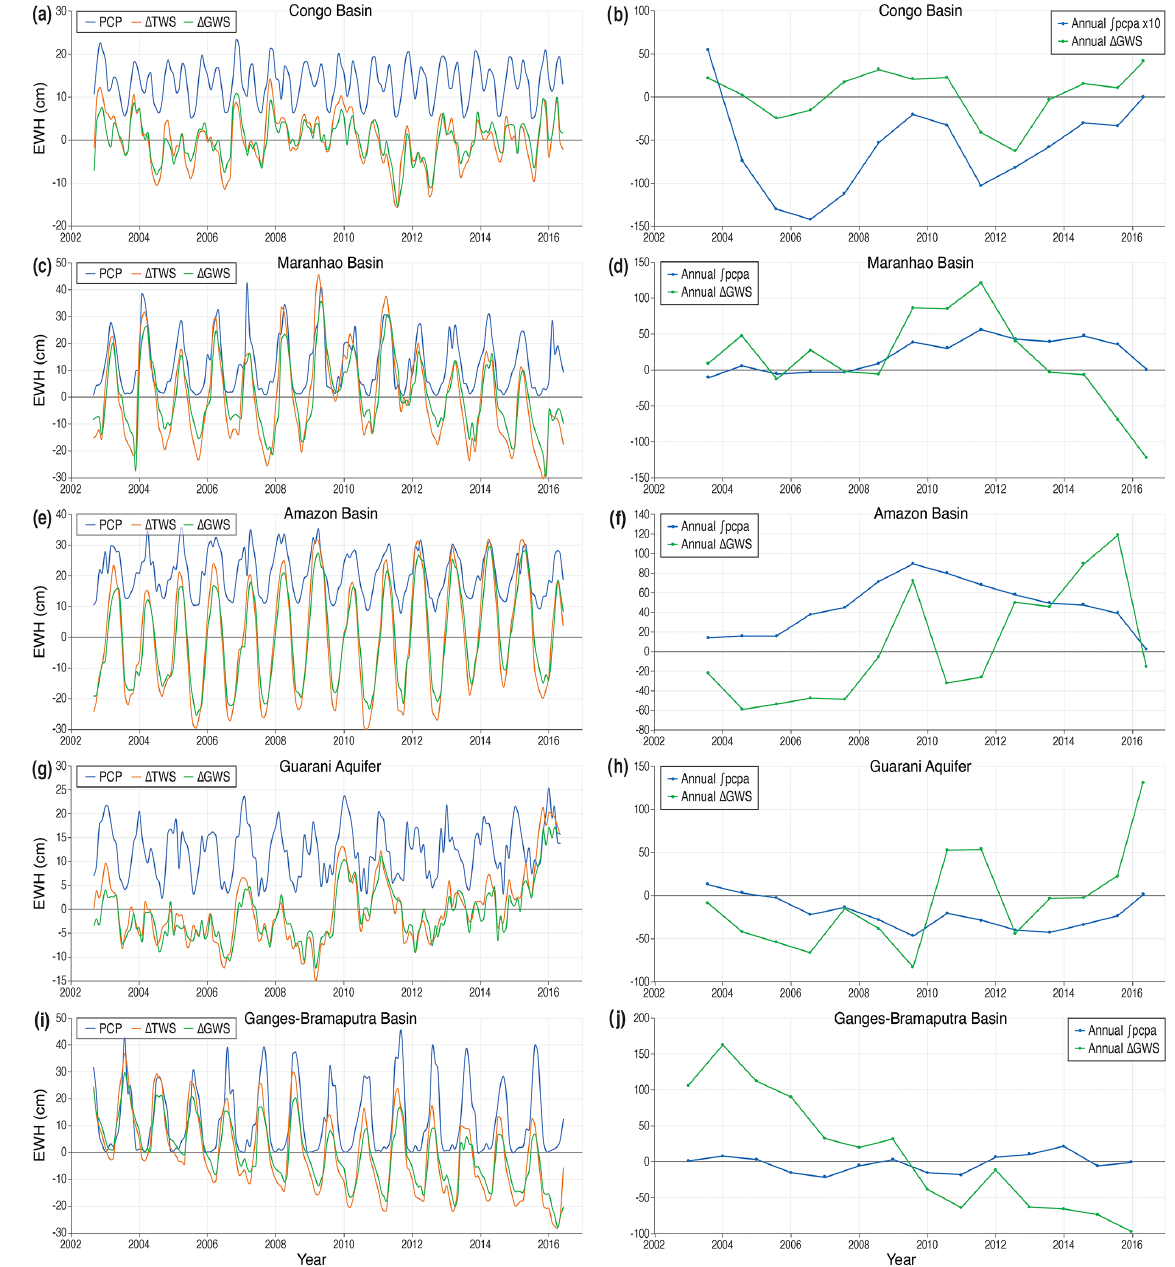
(cid:82) PCPA time series for each of the humid climate zone aquifer Figure 3. Monthly (cid:49) TWS and (cid:49) GWS vs. PCP and annual (cid:49) GWS vs. systems, as labelled. Systems are ordered by decreasing PCC for annual (cid:49) GWS vs. (cid:82) PCPA. All time series are plotted to the aquifer system lag as set out in Table 3, where (cid:49) TWS lags PCP by the specified number of months. Y -axis units are equivalent water height (EWH) in centimetres. Note the variation in the y -axis scales. The Congo Basin annual (cid:82) PCPA data series has been scaled by a factor of 10 for